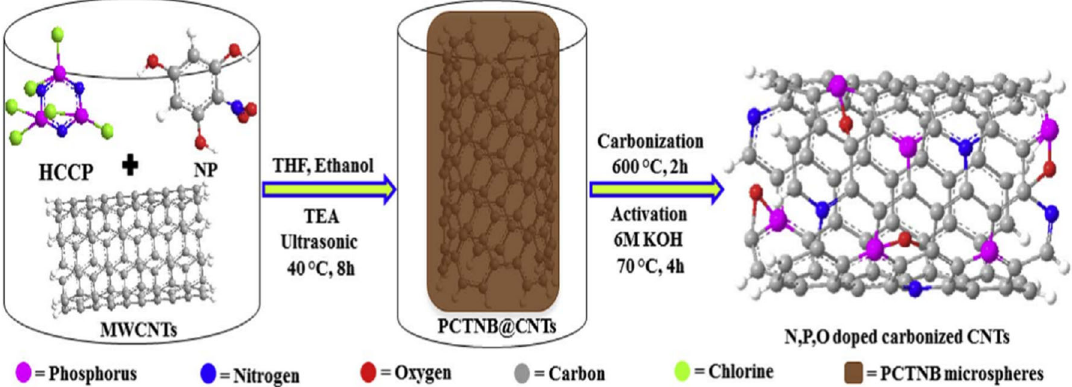
Figure 7. The schematic diagram of the polyphosphazenes hinged N, P, O doped carbonized PCTNB@CNTs ORR electrocatalysts. Taken with permission from [127].